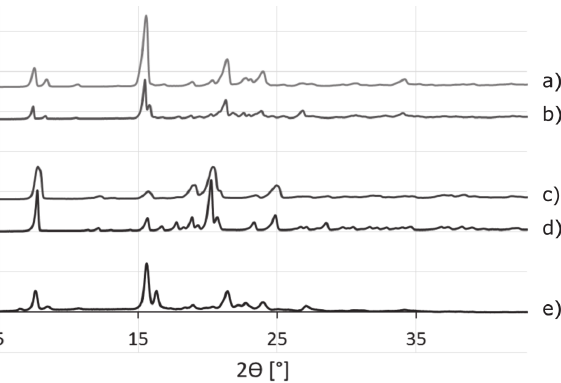
Fig. 3 XRD patterns of diastereomeric salts a) S,R salt, atmospheric, b) S,R -salt GAS, c) S,S -salt, Fig. 3 – XRD patterns of diastereomeric salts a) (S,R) salt, atmospheric, b) (S,R)-salt GAS, c) (S,S)-salt, atmospheric, atmospheric, d) S,R -salt, GAS, e) rac-MPAA- ( R )-CHEA salt (0.5 molar ratio) d) (S,R)-salt, GAS, e) rac-MPAA- (R)-CHEA salt (0.5 molar ra- tio) Scanning Electron Microscopy (SEM) confirmed the formation of fibrous, elongated needle-like crystals under GAS conditions. Higher crystallinity was observed under scCO 2 conditions than under atmospheric conditions via 4-6 hours crystallization time. Crystallization at atmospheric conditions using Tol-ACN mixed solvent shows different crystal habits (Figure 4); however, the crystal structures were similar for salts prepared with atmospheric and gas antisolvent technique.